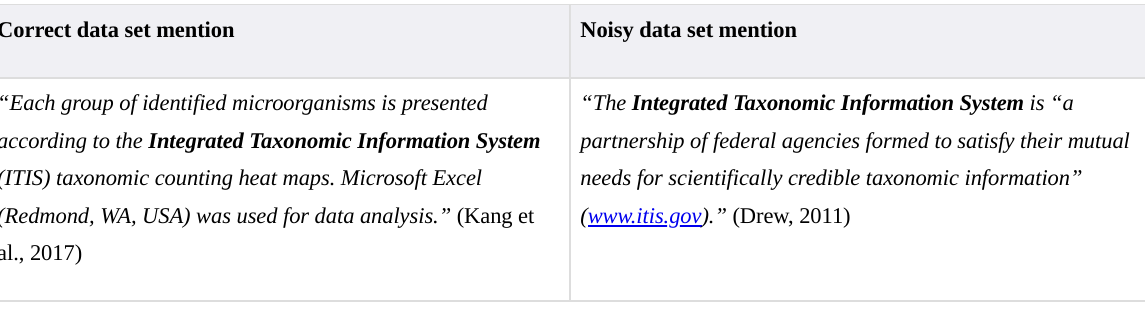
Table B3. Example of correct and noisy data set